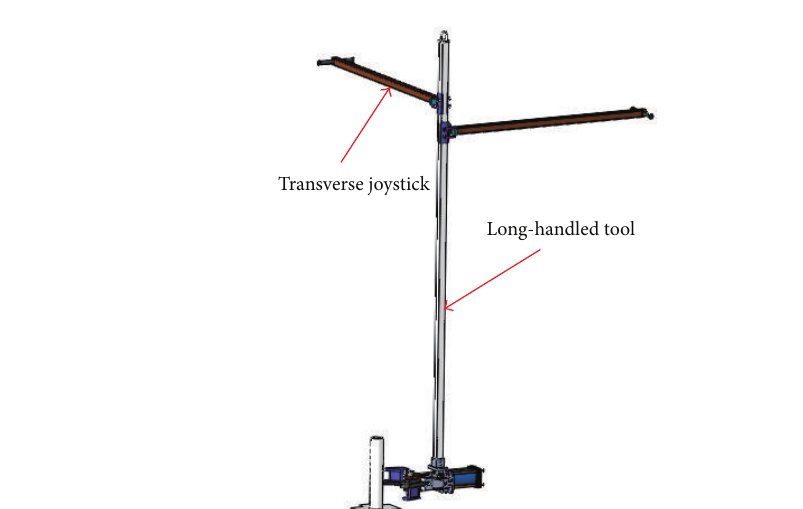
Figure 3: Hydraulic cutter.